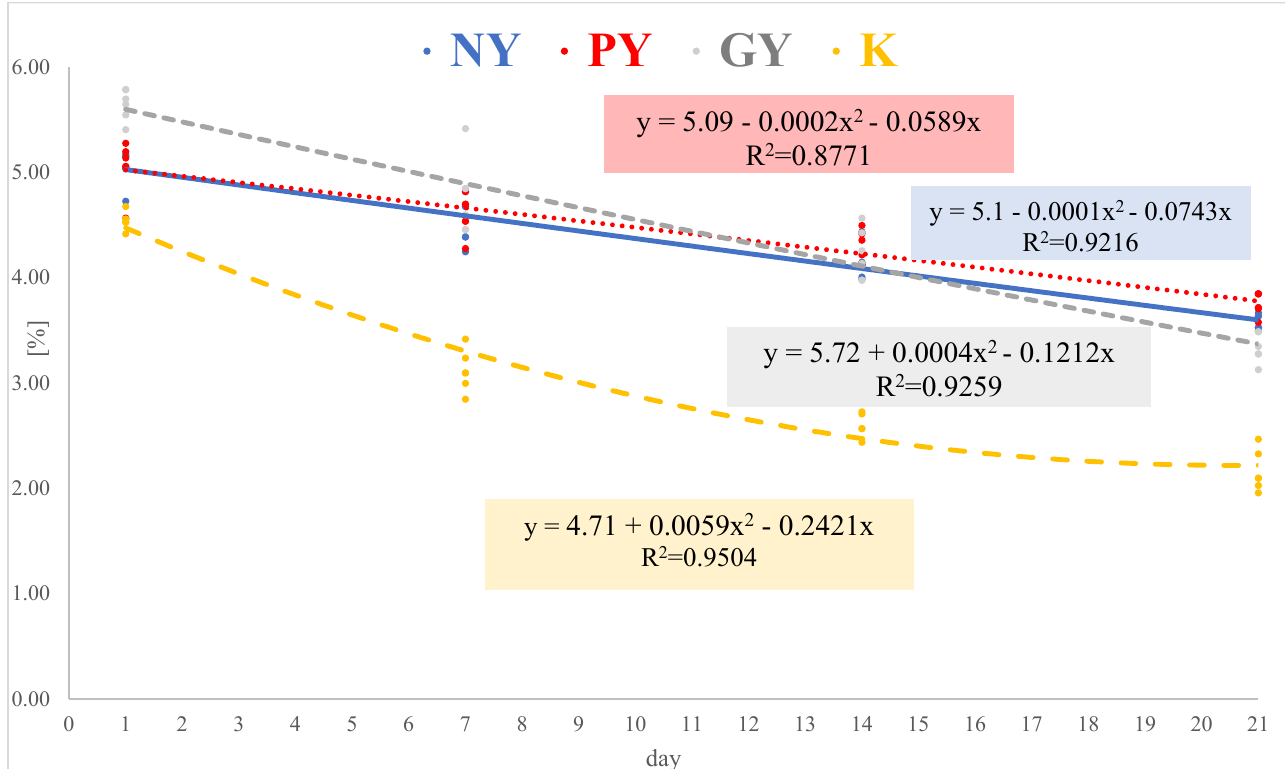
Figure 1. Linear trends in the concentration of lactose during storage. R 2 —determination coefficients of the linear equation. NY—Natural yogurt, PY—Probiotic yogurt, GY—Greek yogurt, and K—Kefir.